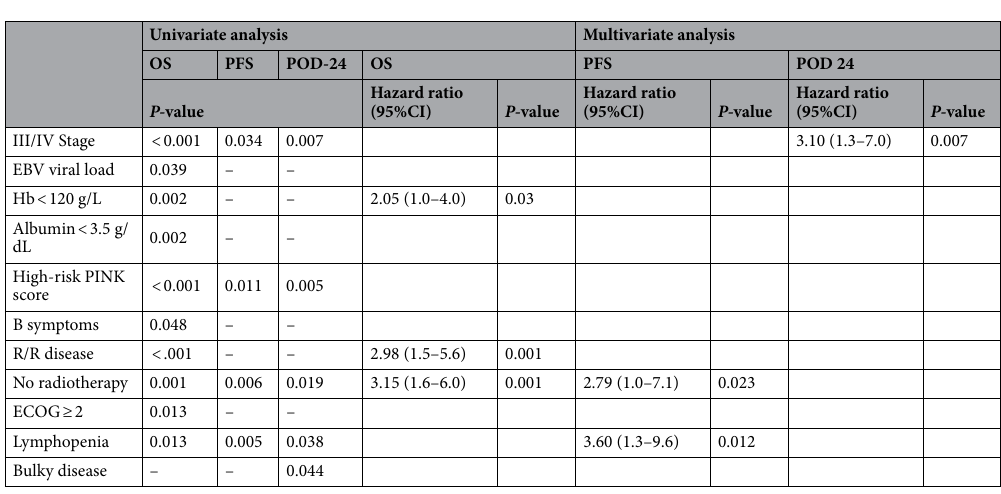
Table 4. Prognostic factors for OS, PFS and POD-24 – univariate and multivariate analysis. R/R disease relapsed/refractory disease, ECOG Eastern Cooperative Oncology Group – Performance status scale.